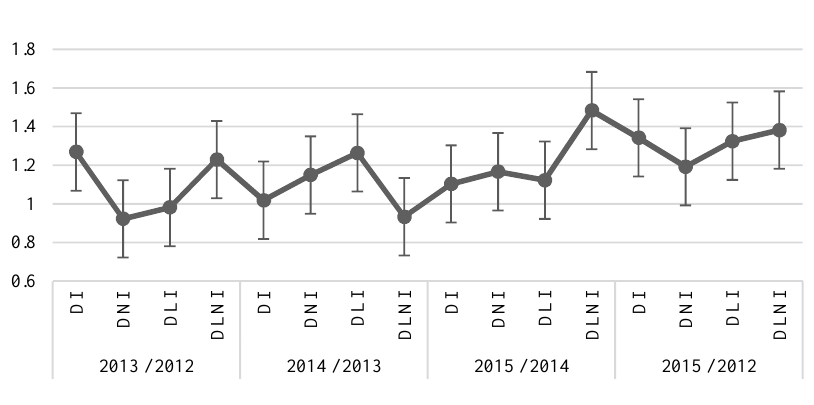
Figure 2. Means values of growth rates with 95% confidence interval for the indicator “Value of shipped products” in innovative (I) and non-innovative (NI) sectors of D and DL for AIRR regions of Russia in 2012–2015